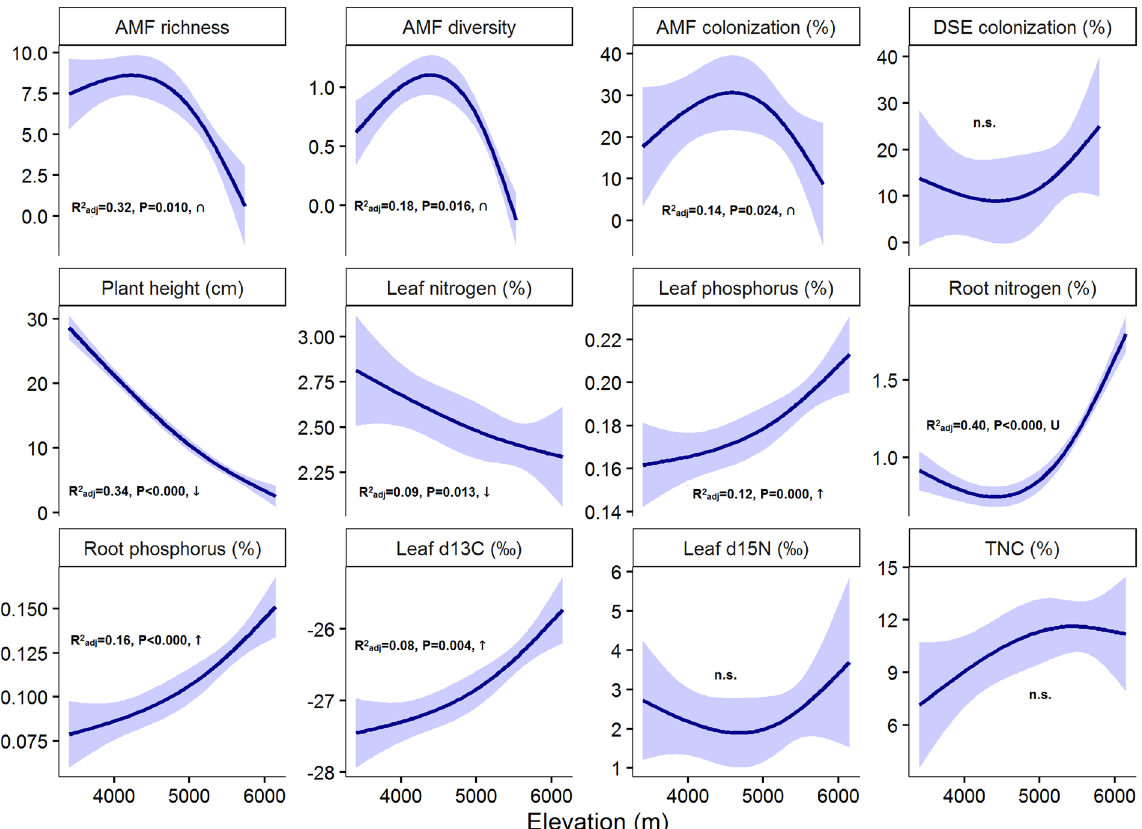
Figure 4. The influence of elevation on AMF attributes and plant traits analyzed using the RLM (Robust Fitting of Linear Models, thick lines), shown with 95% confidence intervals. AMF richness and diversity refers to number and Shannon diversity of OTUs. TNC - total nonstructural